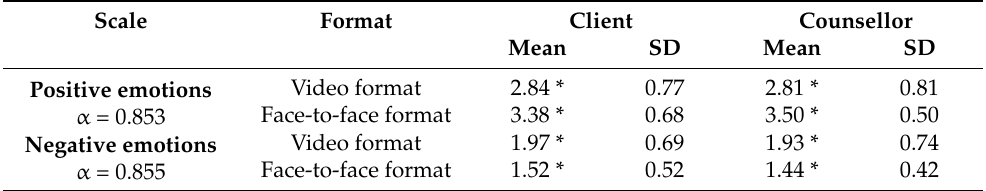
Table 2. Mean values of the emotion scales by format.